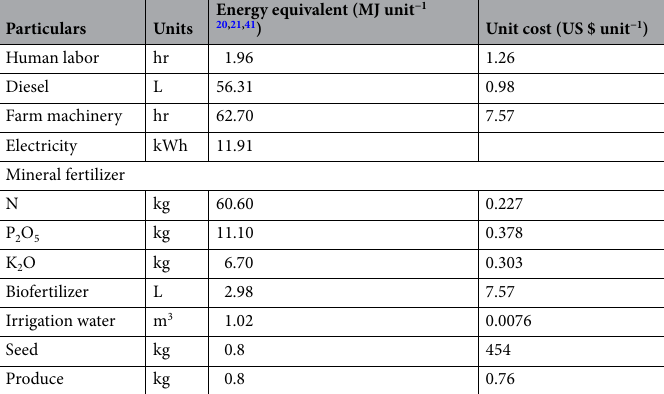
Table 8. Energy equivalents and cost of inputs and outputs in red cabbage production. 1 US $ = 66 INR.